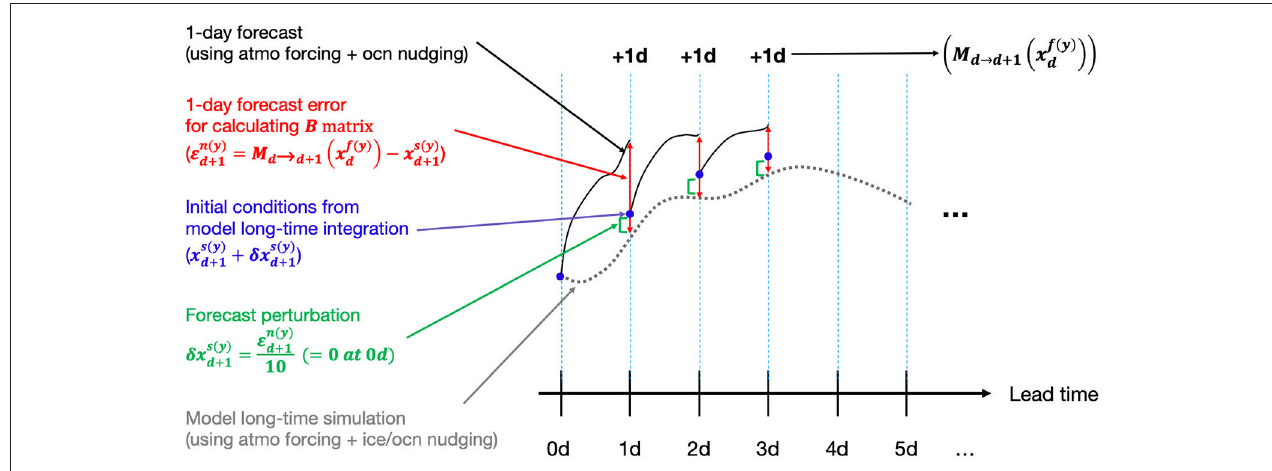
FIGURE 1 | The schematic of the generation system for forecast error perturbations of ε n ( y ) d + 1 for calculating stationary background error covariance matrix (i.e., B matrix). The black (dotted) line represents the model long-time simulation nudged sea ice and ocean reanalysis with atmospheric forcing and the black (solid) line represents the 1-day forecast experiments forced atmospheric forcing data without restoring sea ice fields. The blue dot represents the initial conditions from the model long-time simulation. The red bidirectional arrow represents the 1-day forecast errors and the green left bracket represents the forecast perturbations using the bred